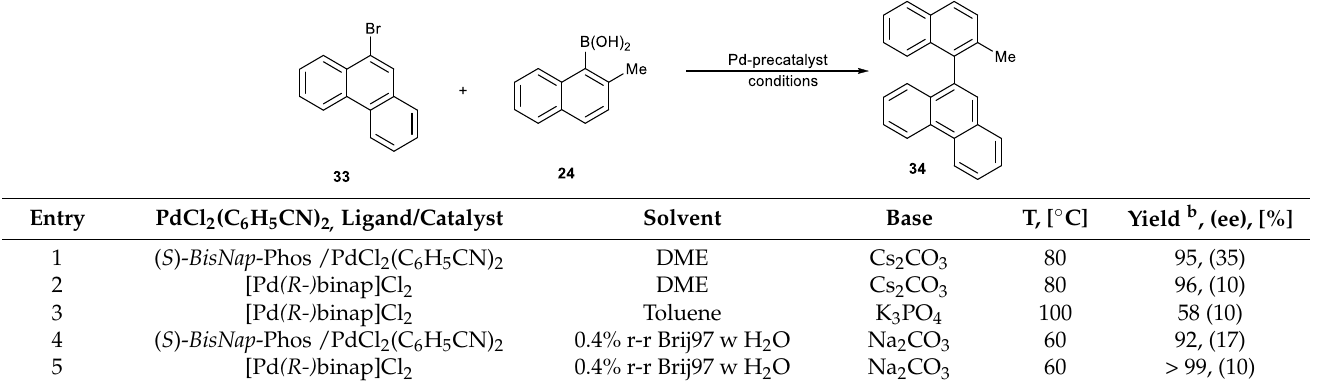
Table 17. Synthesis of biaryls bearing mild-coordinating functional groups a .